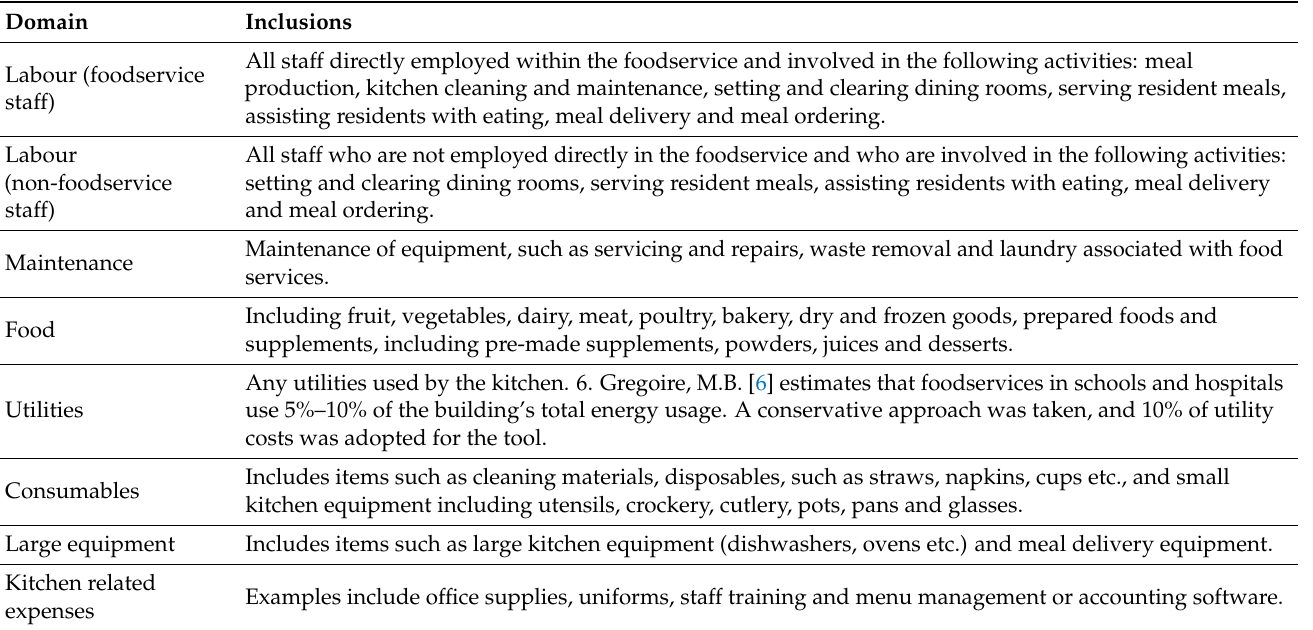
Table 1. Inclusions for each